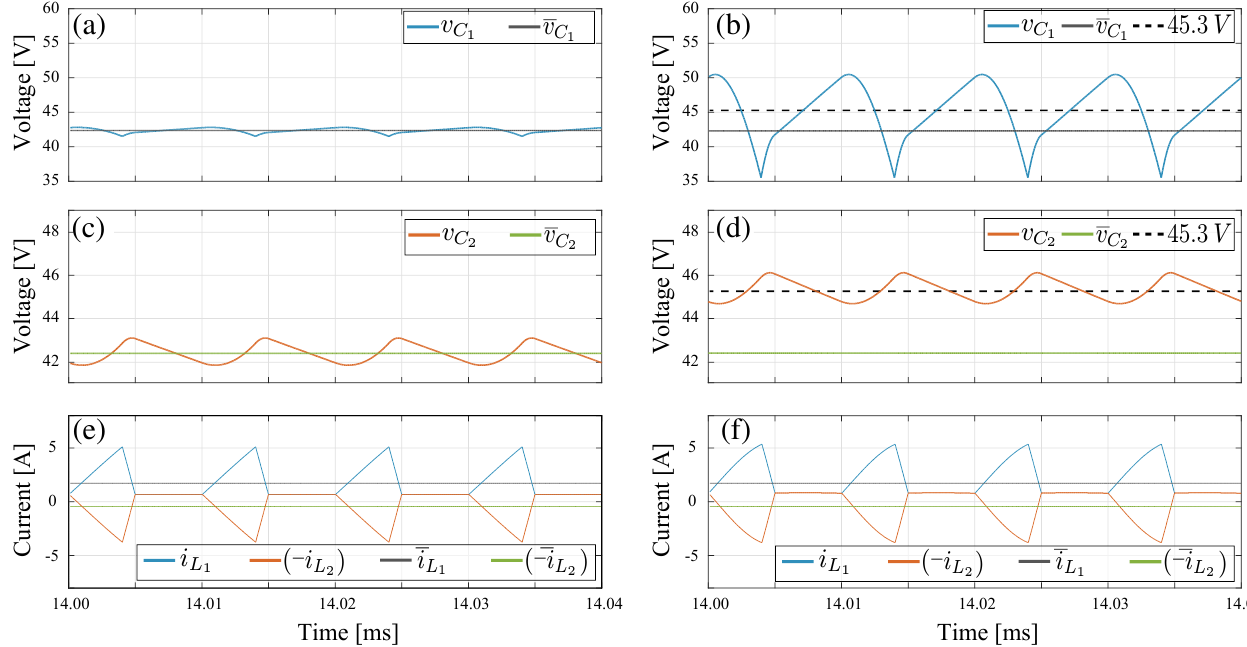
Figure 8. Comparison results for capacitor voltages in Zeta converter with negative magnetic coupling: ( a , b ) intermediate capacitor voltage ( v C ), ( c , d ) output capacitor voltage ( v C ), ( e , f ) inductor current, ( a , c , e ) C 1 = 5 µ F, ( b , d , f ) C 1 = 0.5 µ 2 1